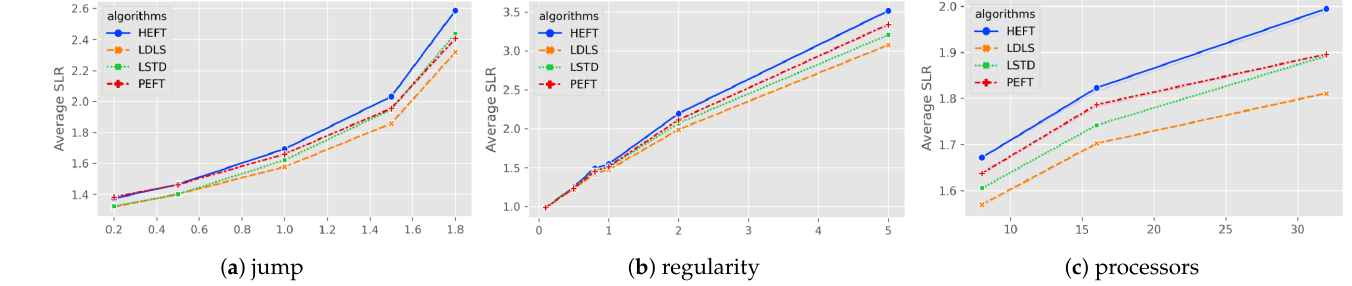
Figure 6. Average SLR for montage as a function of ( a ) heterogeneity of processors; ( b ) communication to computation ratio; ( c ) number of